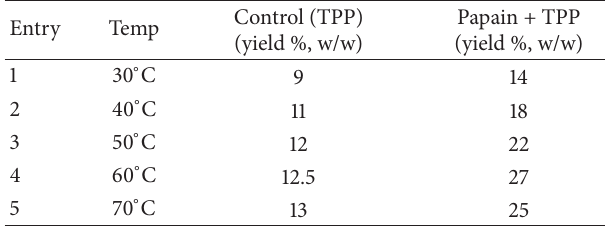
Figure 2: Effect of the use of papain on oil yield. The algal suspension was given a treatment of ultrasonication as described in the method section and was incubated at 40 ∘ C with crude papain (2 g) at pH 6 with magnetic stirring along with a control (without enzyme) and then a Three-Phase Partitioning was done as described before with 50% ammonium sulphate. In each case the yield of the oil was expressed in w/w, dry weight of the algae. Each set was performed in triplicate and the deviation between the experimental data was within 3%. Table 2: Effect of temperature on papain assisted oil extraction (by TPP). The sonicated aqueous suspension of algae containing 2 g of crude papain (100 units) was incubated at pH6 at different temperatures for 6h as optimized earlier and it was subjected to three-phase partitioning. The control was the suspension without enzyme. The yield of the oil in each case was noted and expressed in terms of %, w/w, dry weight of